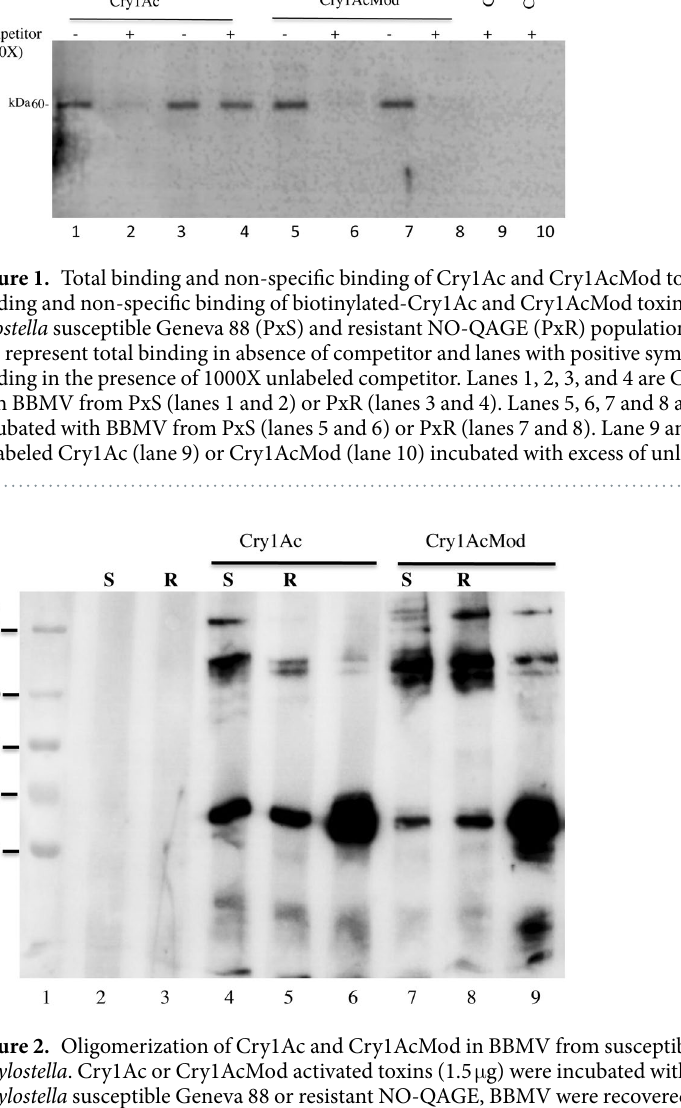
Table S1, paired t-test, t = 6.4, df = 2, P = 0.02). Insertion of Pre-formed Cry1Ac Oligomer in BBMV from Both Strains.